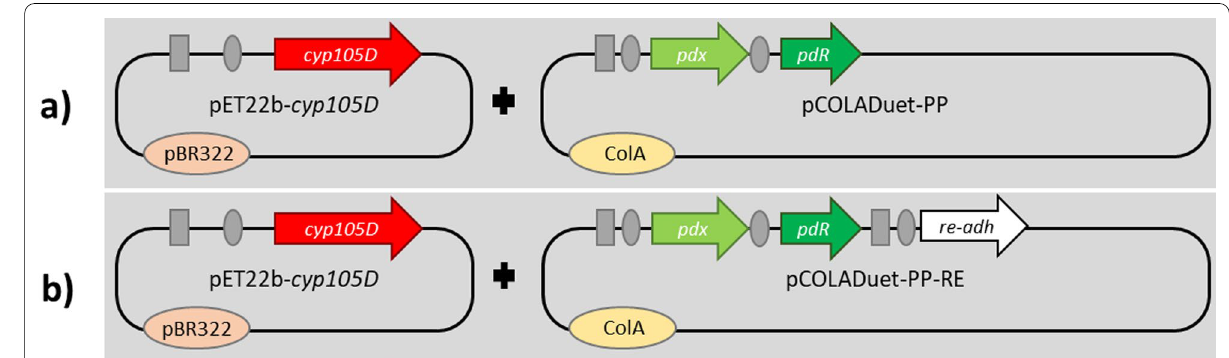
Fig. 2 Plasmid combinations used in this study for whole-cell biocatalyst design. The P450 gene cyp105D is always encoded on the pET22b-vector. Redox partner genes ( pdx/pdr ) are integrated in MCSI of pCOLADuet. The re-adh gene ( b ) is integrated in the MCSII of the pCOLADuet-vector. Gray squares represent the T7-promoter; gray circles indicate the ribosome binding